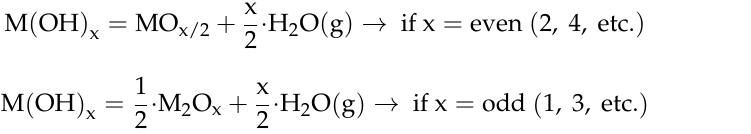
Ca(II), Cd(II), Co(II), Cu(II), Fe(II) and Mg(II). Thus, all these eight metal ions obey con ‐